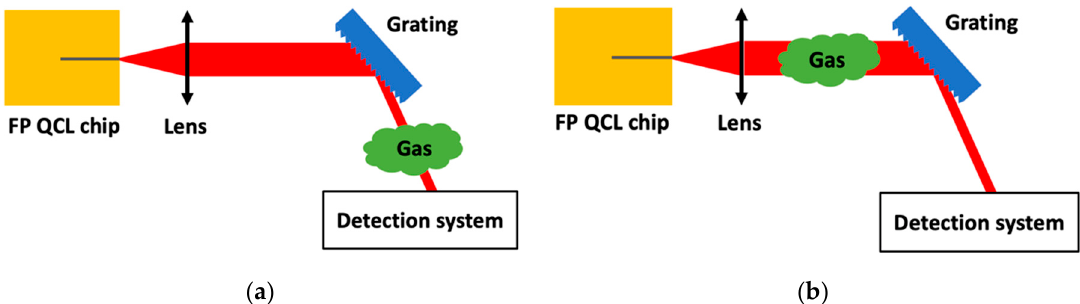
Figure 8. ( a ) Schematic of a standard Fabry–Pérot Quantum Cascade Laser chip source in an external-cavity system for gas detection in front facet Littrow configuration and ( b ) the same set-up used to perform Intra-Cavity Laser Absorption Spectroscopy.